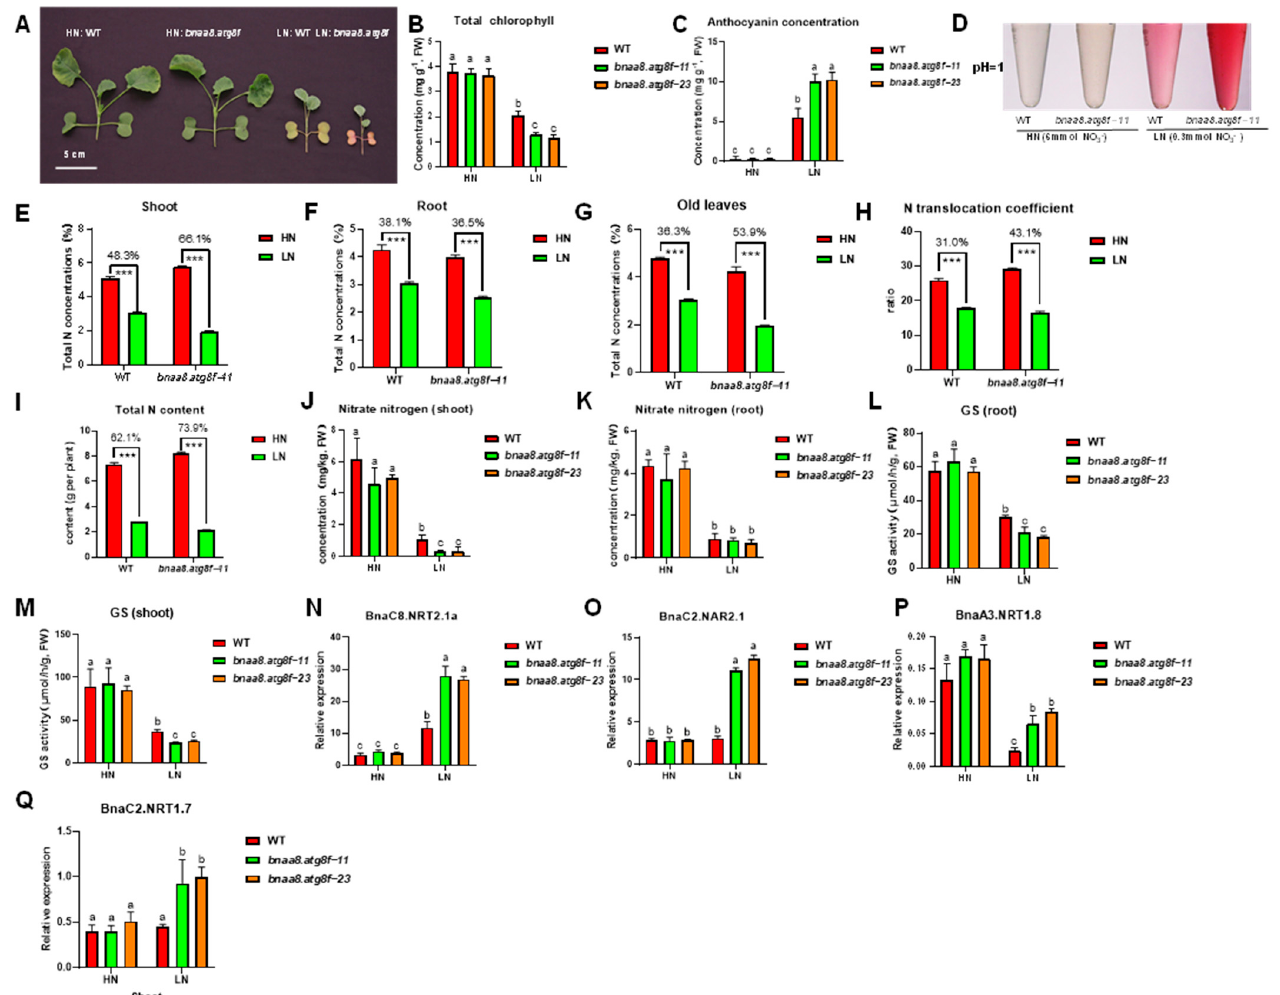
Figure 6. Down-regulation of BnaA8.ATG8F reduced adaption to nitrogen limitation. ( A ) Representative images of leaves of the wild type and bnaa8.atg8f after 10 d treatment with HN, 6 mM NO 3 − and LN, 0.3 mM NO 3 − . ( B ) Chlorophyll concentrations in young leaves ( C ) Anthocyanin concentrations in the shoots. ( D ) Representative images of anthocyanin extract at pH = 1.0. ( E – G ) Total N concentrations in the ( E ) shoots, ( F ) roots, and ( G ) old leaves. ( H ) N translocation coefficient (shoot/root). ( I ) Total N content in the whole plants. ( J ) Nitrate N in the shoots. ( K ) Nitrate N in the roots. ( L ) GS activity in the roots. ( M ) GS activity in the roots. ( N – Q ) Relative expression of ( N ) BnaC8.NRT2.1a in the roots, ( O ) BnaC2.NAR2.1 in the roots, ( P ) BnaA3.NRT1.8 in the roots, ( Q ) BnaC2.NRT1.7 . in the old leaves between wild type and bnaa8.atg8f . Significant differences were determined using either Student’s t -test (***, p < 0.001) or one-way ANOVA followed by Tukey’s HSD test ( p <